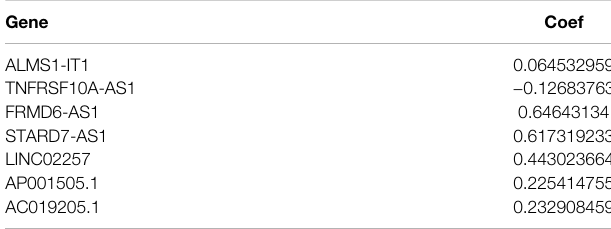
TABLE 1 | The correlation coef fi cients of 7 RNA methylation-related lncRNAs.